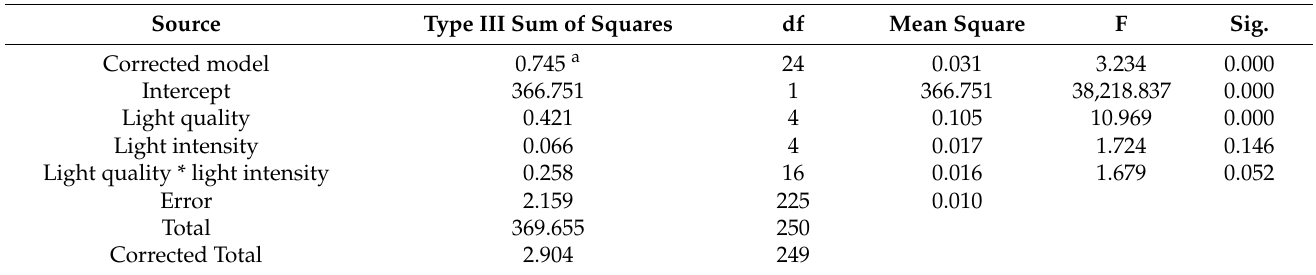
Table 3. Examination of the intrasubject effect of different light qualities and light intensities on the diameter ratio of the cap and stipe of P. eryngii .